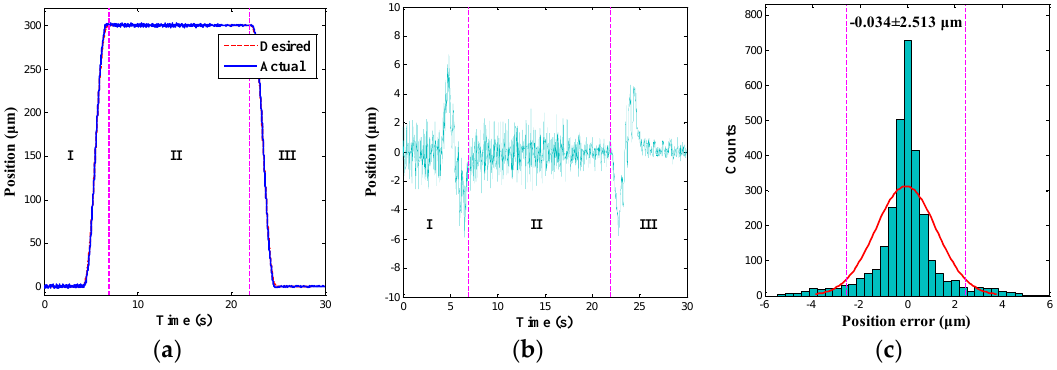
Figure 10. Position control results of a cycloid trajectory. ( a ) Position tracking result; ( b ) Position tracking error; and ( c ) Histogram of position tracking error.